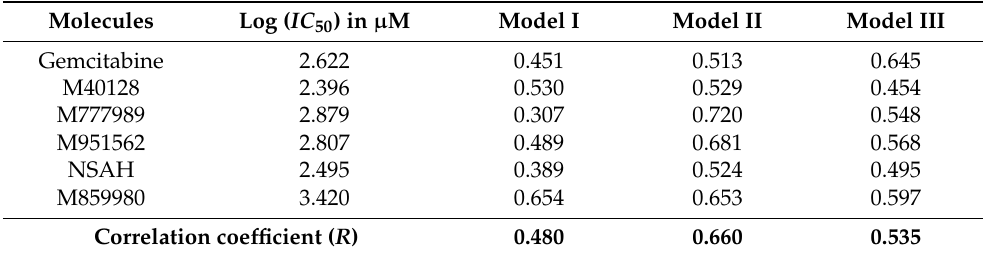
Table 1. Experimental inhibitory concentration and ShaEP score based on three models for known hRRM1 inhibitors.